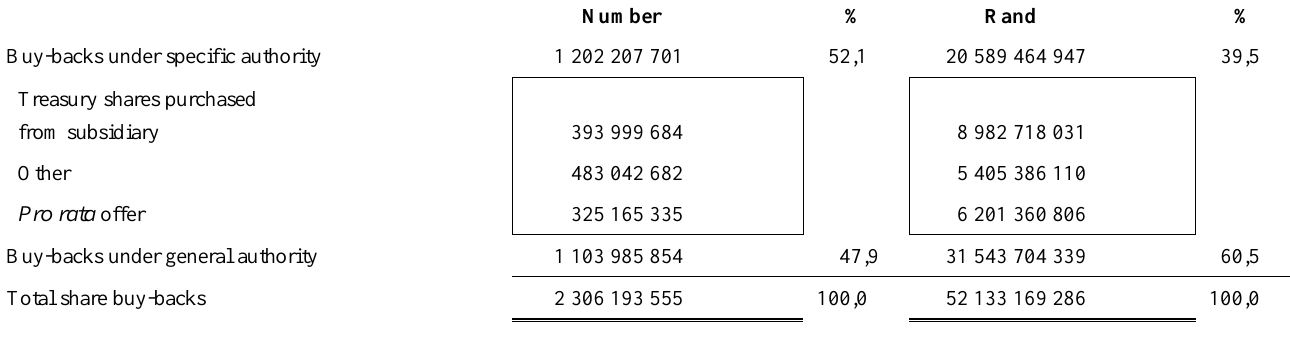
Table 3: Share buy-backs: specific vs. general authority Number % Rand %